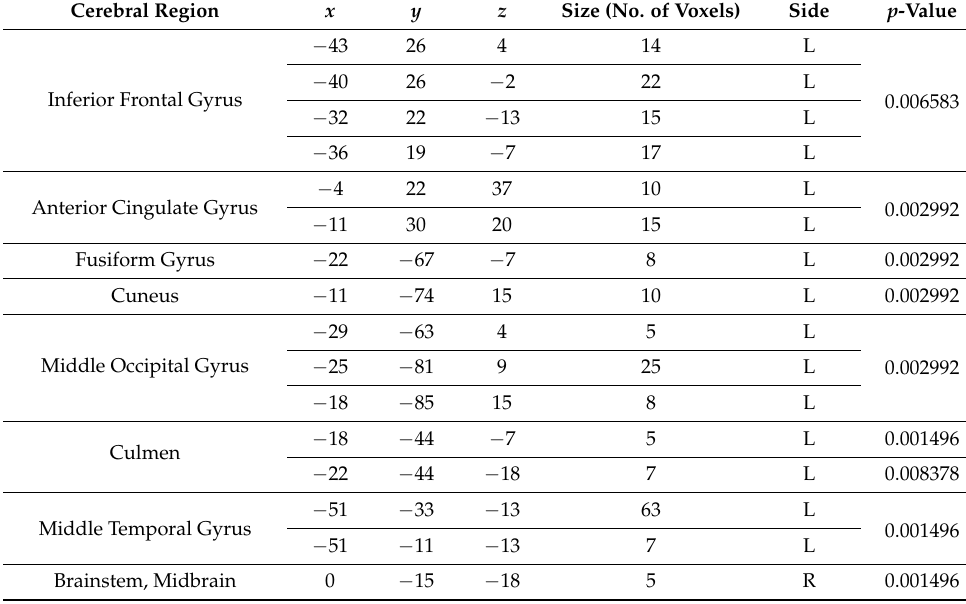
Table 3. Regions of brain activation (Talairach coordinates) showing significantly greater correlation with the number of A alleles of the AKT1 rs1130233 polymorphism under THC condition than under placebo condition while viewing fearful faces. L and R indicate the left and right hemisphere. y z Size (No. of